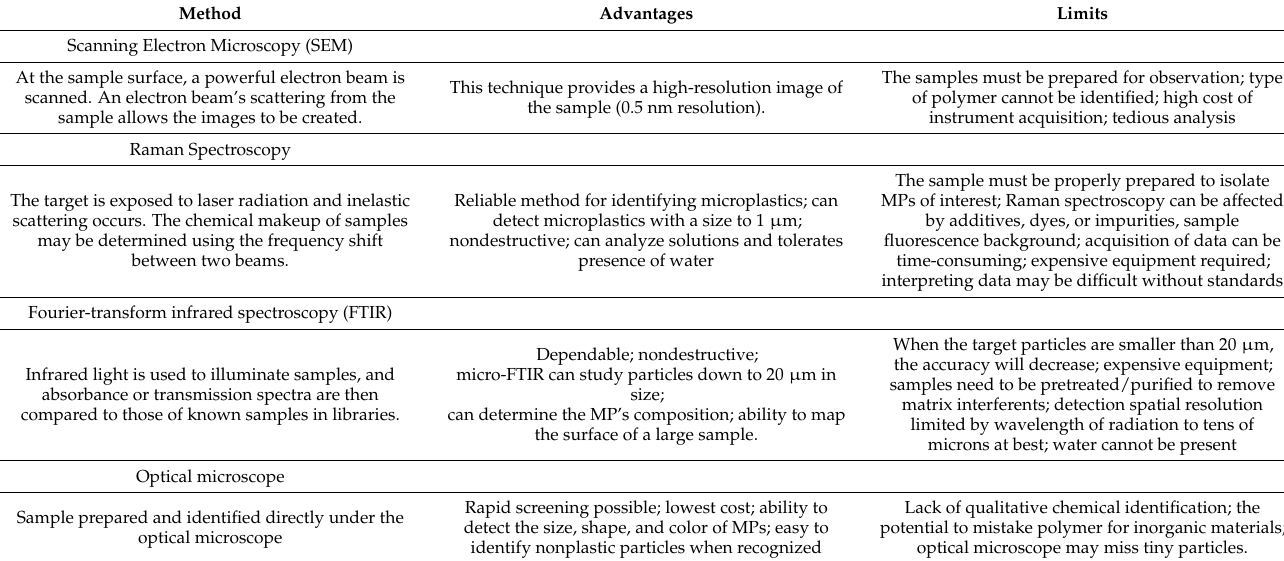
Table 1. Comparison of techniques for microplastics